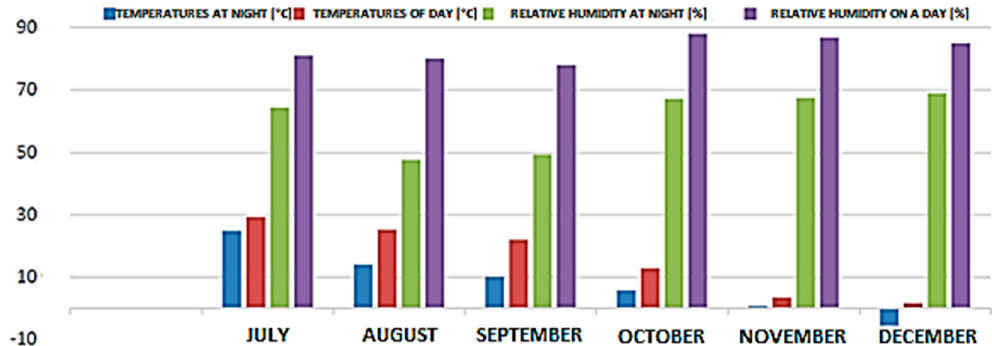
Figure 4. The average climatic conditions during the storage of beech and oak logs.